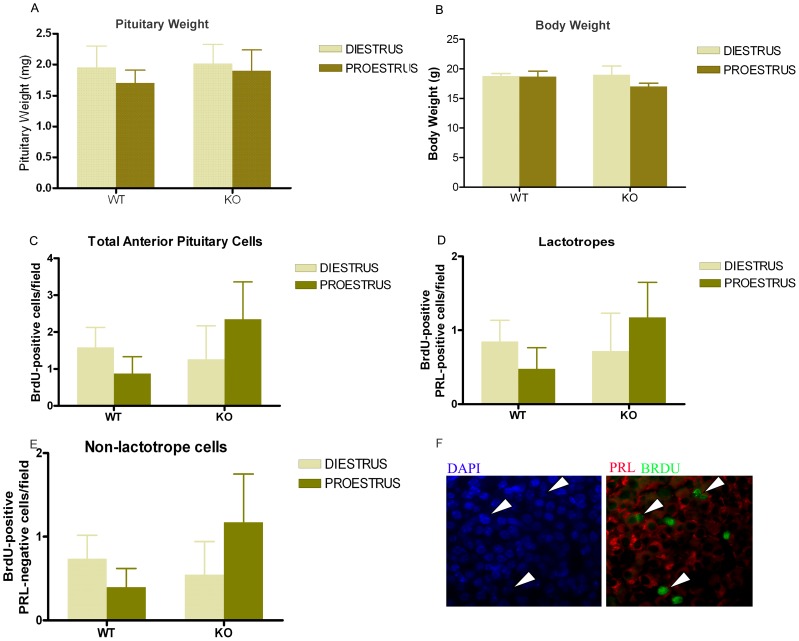
Anterior pituitary cell proliferation in WT and PRLR KO mice at proestrus or diestrus.Wild type and PRLRKO mice (6–10 animals per group) were injected with BrdU (50 mg/kg, 24 h) and sacrificed at proestrus or diestrus. Proliferation was determined by BrdU incorporation in tissue sections. A, B: Body weight (A) and pituitary weight (B) of WT and PRLRKO mice euthanized at diestrus or proestrus, expressed as mean ± SEM, two-way ANOVA. C: Each column represents the media ± SEM of proliferating total anterior pituitary cells (BrdU-positive cells/field). Two-way ANOVA. D: Each column represents the media ± SEM of proliferating lactotropes (BrdU-positive PRL positive cells/field), Two-way ANOVA. E: Each column represents the media ± SEM of proliferating non-lactotrope cells (BrdU-positive PRL-negative cells/field). Two-way ANOVA. F: Representative microphotographs of anterior pituitaries from KO mice euthanized at proestrus. Arrow heads indicate BrdU-positive lactotropes. Arrows indicate BrdU-positive cells.